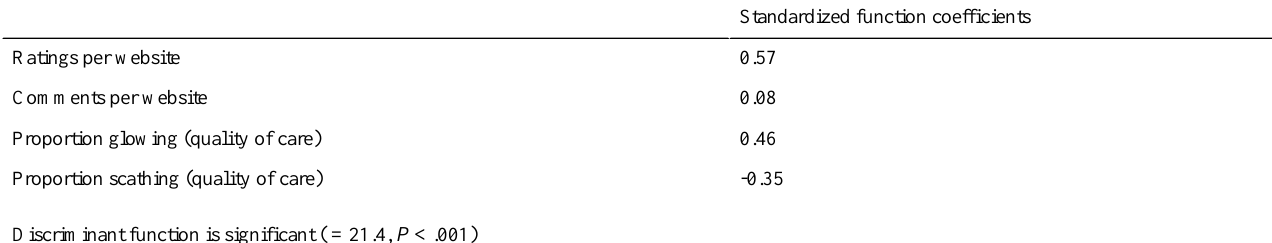
Table 10. Discriminant function analysis results.